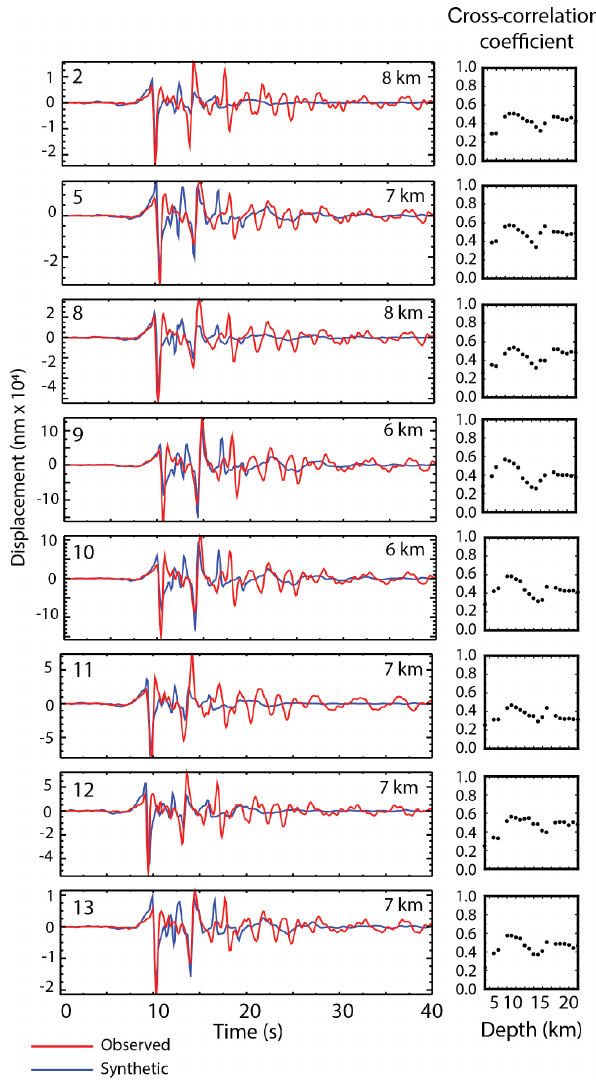
Figure 7. Transverse component of the S-wave ground displace- ment (in nanometers) for eight of the largest earthquakes in the sequence recorded at station ALCN (see Fig. 1 for location). Red lines are the observed data, and blue lines are the synthetic wave- forms for the best fitting depth. Event number according to Table 3 is indicated in the upper left of each seismogram, and best fitting focal depth in the upper right. The right panels show the cross- correlation coefficient between the observed and synthetic displace- ment seismograms as a function of depth. All events show low cross-correlation values for shallow depths (less than 2–4km) and a clear maximum between 6 and